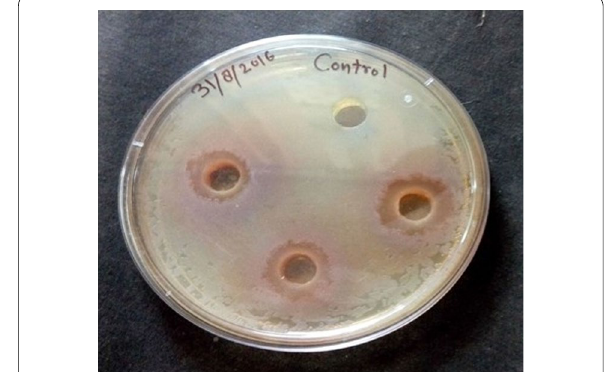
Fig. 1 Antibacterial activity of Syzygium cumini methanolic seed extract against MTCC 2413 Bacillus subtilis at the concentration of 25